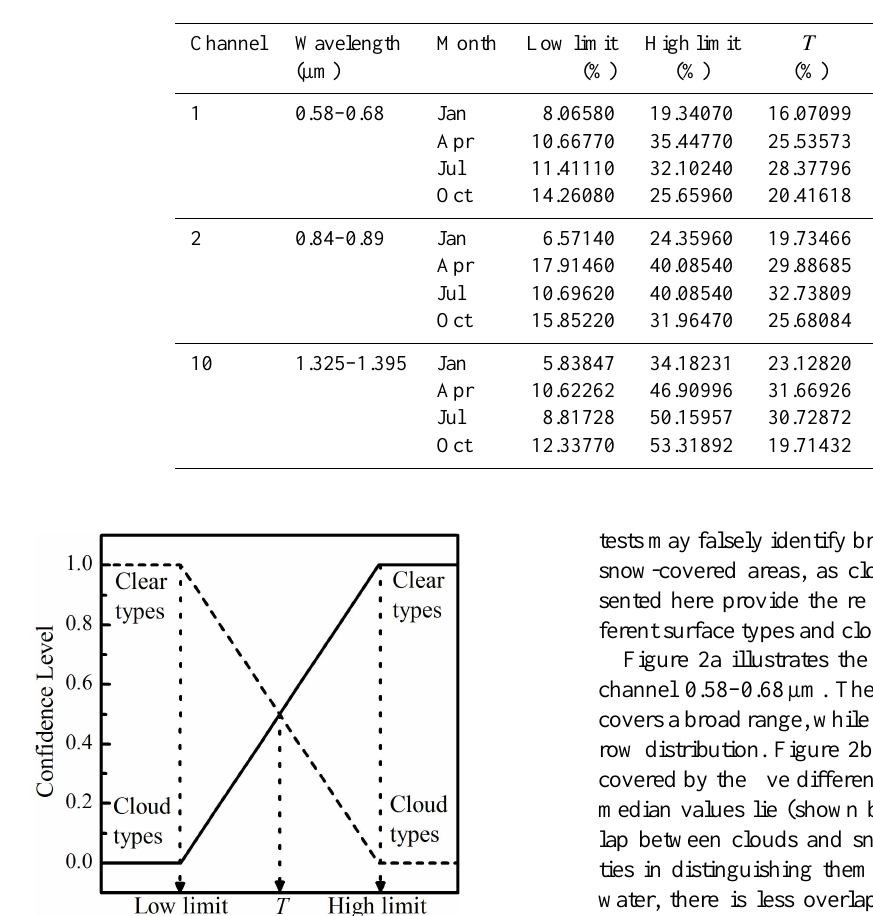
Table 2. Threshold values of single reflectance tests during four seasons.